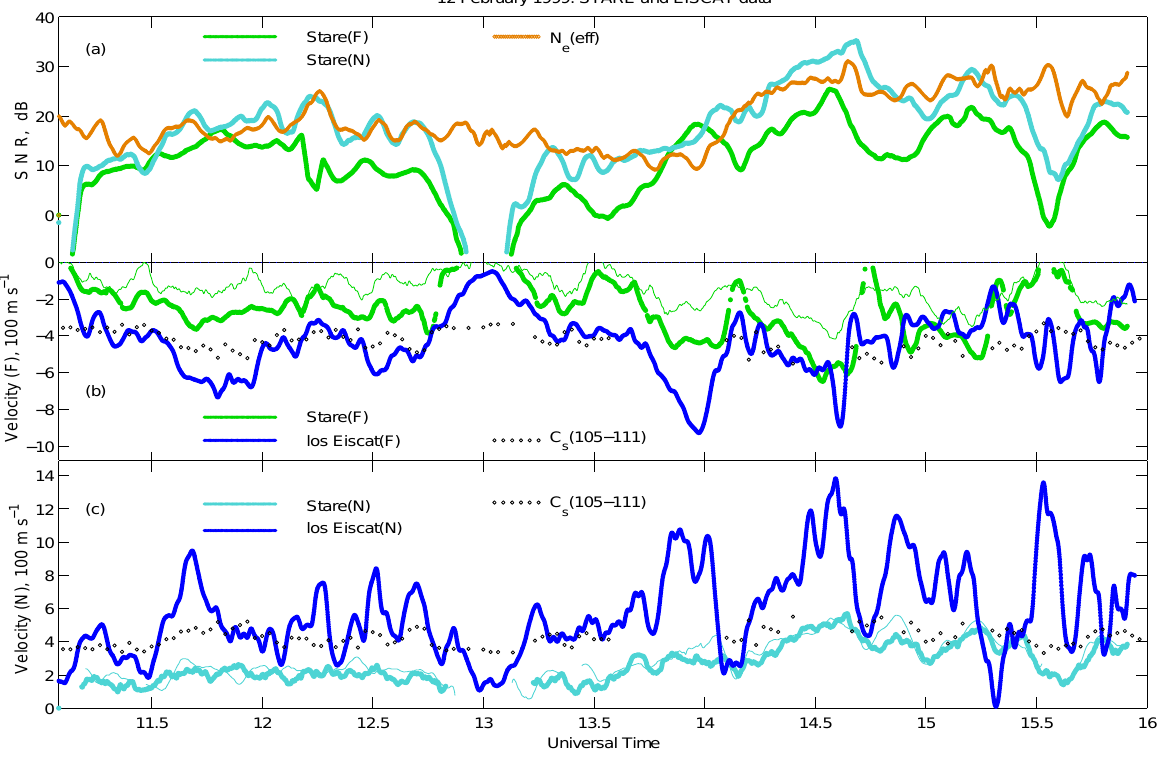
Universal Time Fig. 2. The STARE (Finland radar beam 4 and the Norway radar beam 4) and EISCAT parameters: (a) SNR, green line for Finland and light Uspensky et al. Fig.2 blue line for Norway; the orange line is the effective electron density (on a logarithmic scale); (b) Finland beam 4 line-of-sight MP and DP velocities, thick and thin green line, respectively, and matched l-o-s EISCAT V E × B velocity component, dark blue line; open black circles in panels (b) and (c) are the isothermal ion-acoustic speed in height interval of 105–111km according to EISCAT; (c) the same as in (b) but for the STARE-Norway beam 4 l-o-s MP and DP velocity, thin and thick light blue line (opposite marking), and matched l-o-s EISCAT V E × B velocity component, dark blue line,